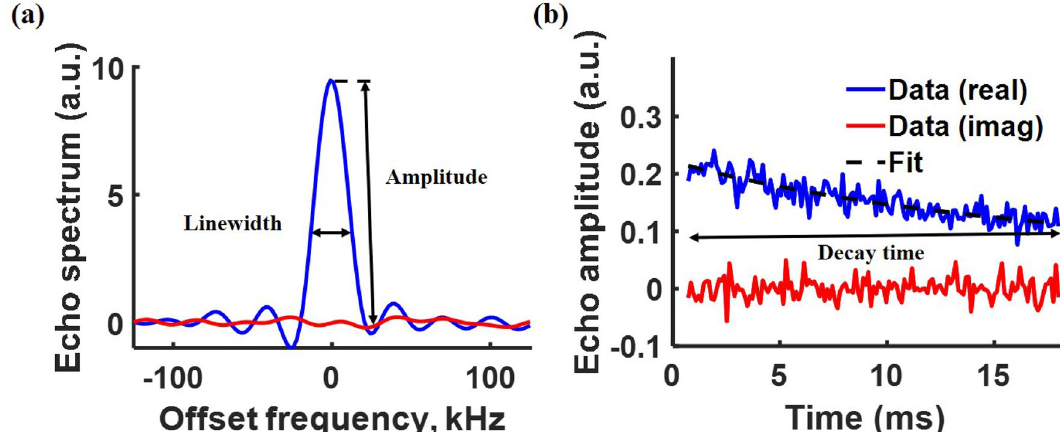
Figure 2. Spin echoes from pulsed NQR measurements using the spin-locked spin echo (SLSE) sequence 15 are collected, filtered, and fitted to exponential decay curves. Assuming a mono-exponential decay, the resulting function contains three useful features. ( a ) Typical echo spectrum (shown as a function of frequency offset from the nominal resonance frequency). The first feature is the peak signal amplitude A , which is proportional to the number of quadrupolar nuclei within the tag. The second feature is the frequency-domain linewidth (cid:31) f . ( b